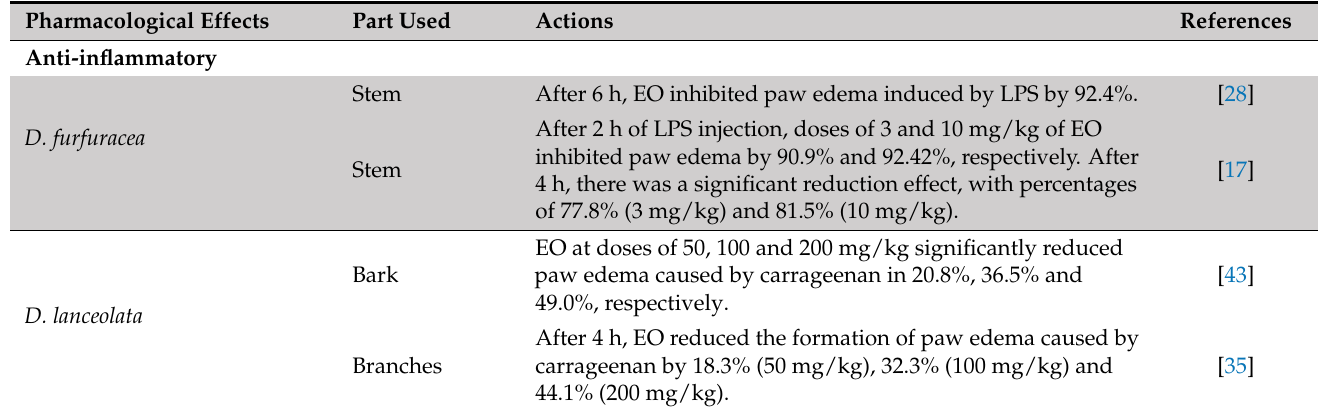
Table 3. Pharmacological properties of Duguetia species